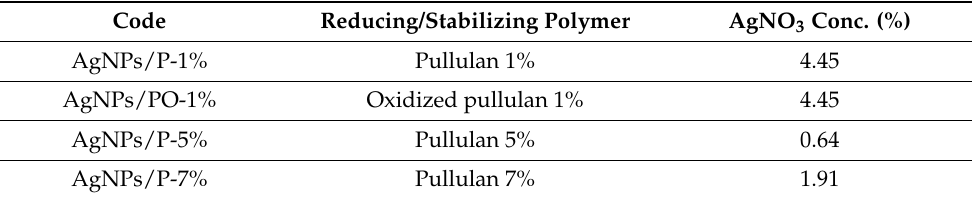
Table 1. Sample codes for the silver nanoparticles synthesized using pullulan (P) and oxidized pullulan (PO) as reducing/stabilizing